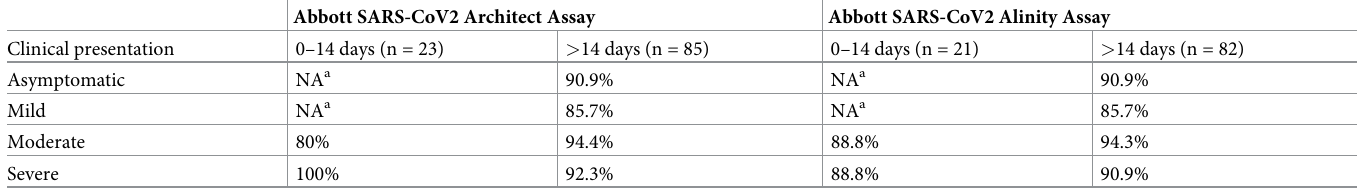
Table 6. Abbott anti-SARS-CoV-2 Architect and Alinity assays performance compared with in-house Elisa reported by clinical presentation